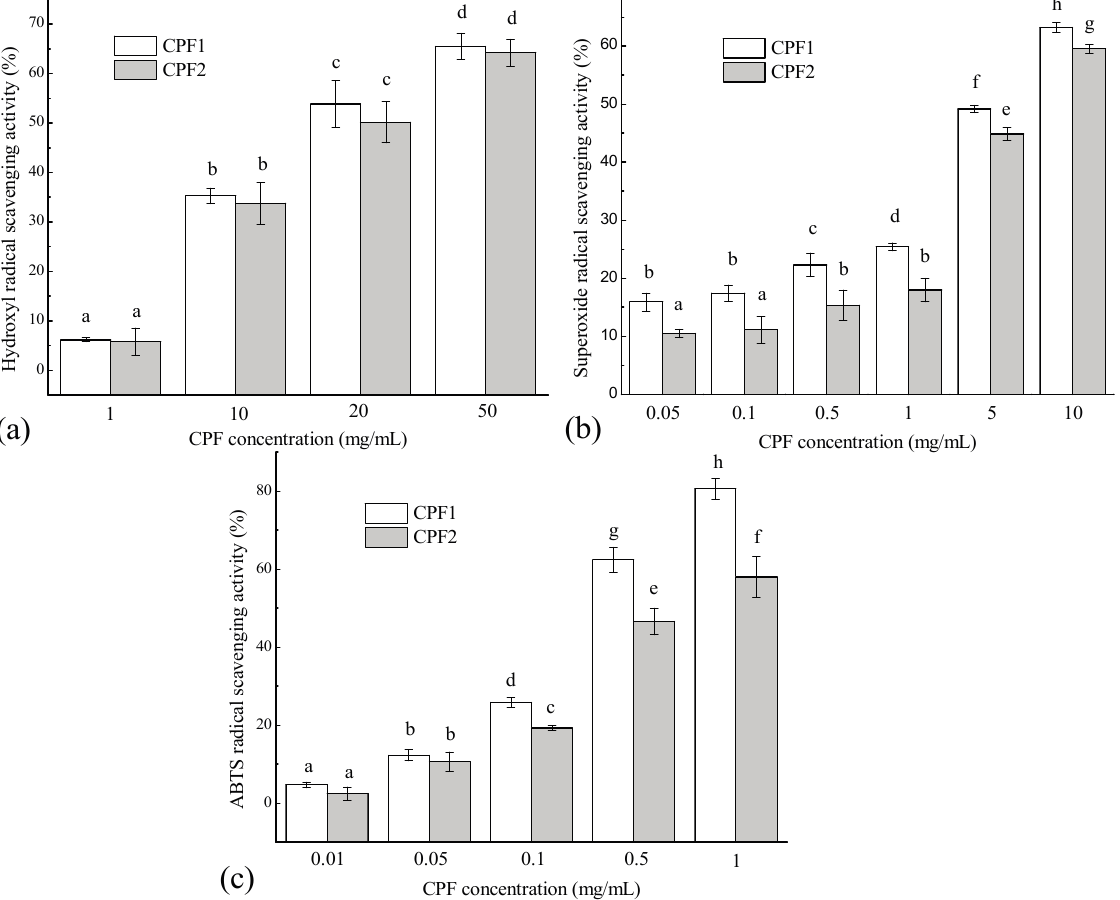
Figure 1. In vitro free radical scavenging activities of CPF fractions. ( a ) Hydroxyl radical scavenging activity; ( b ) Superoxide anion radical scavenging activity; ( c ) ABTS radical scavenging activity. For each measurement, the data marked by different letters are significantly different ( p <